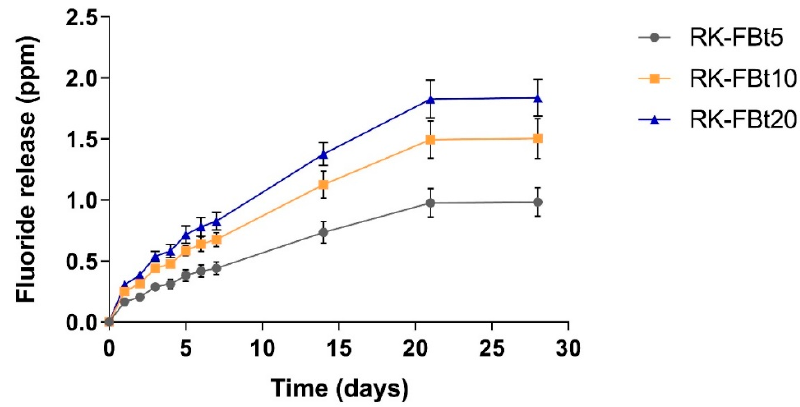
Figure 9. Cumulative release profiles of fluoride ions from RK-FBt5, RK-FBt10, and RK-FBt20 measured by ion chromatography method. Samples were put in mineral medium with composition similar to saliva (SAGF) for 28 days. The bars represent means ± SD ( n = 3).